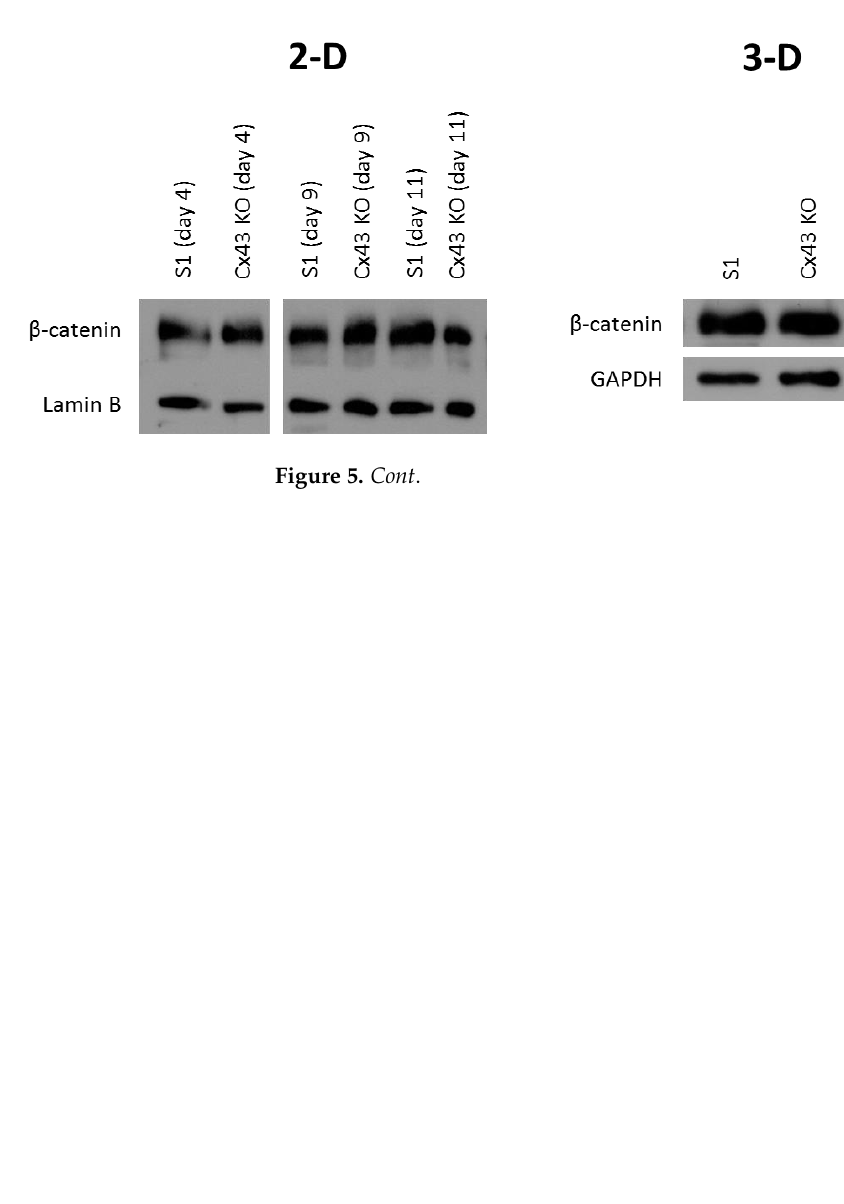
Figure 4. Silencing Cx43 alters the localization of junctional and polarity proteins in S1 cells under 3-D culture conditions without affecting their expression levels. S1 and Cx43-shRNA S1 cells (Cx43 KO) were cultured under 2-D or 3-D conditions. A. Total proteins were extracted on day 9 in 2-D (left panel) and on day 11 in 3-D (right panel). Expression of Scrib, ZO-2, β-catenin and Cx43 was assessed by Western